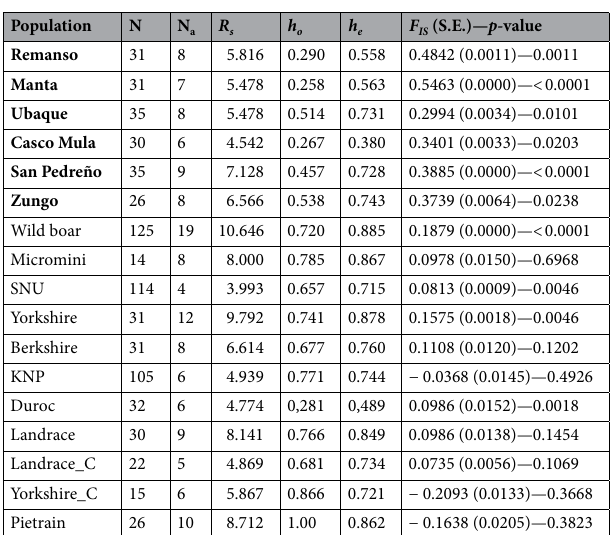
Table 2. Sample size (N), amount of alleles (Na), allele richness ( Rs ), observed heterozygosity ( ho ), expected heterozygosity ( he ) and F IS values for analysed pig populations. p < 0.05.